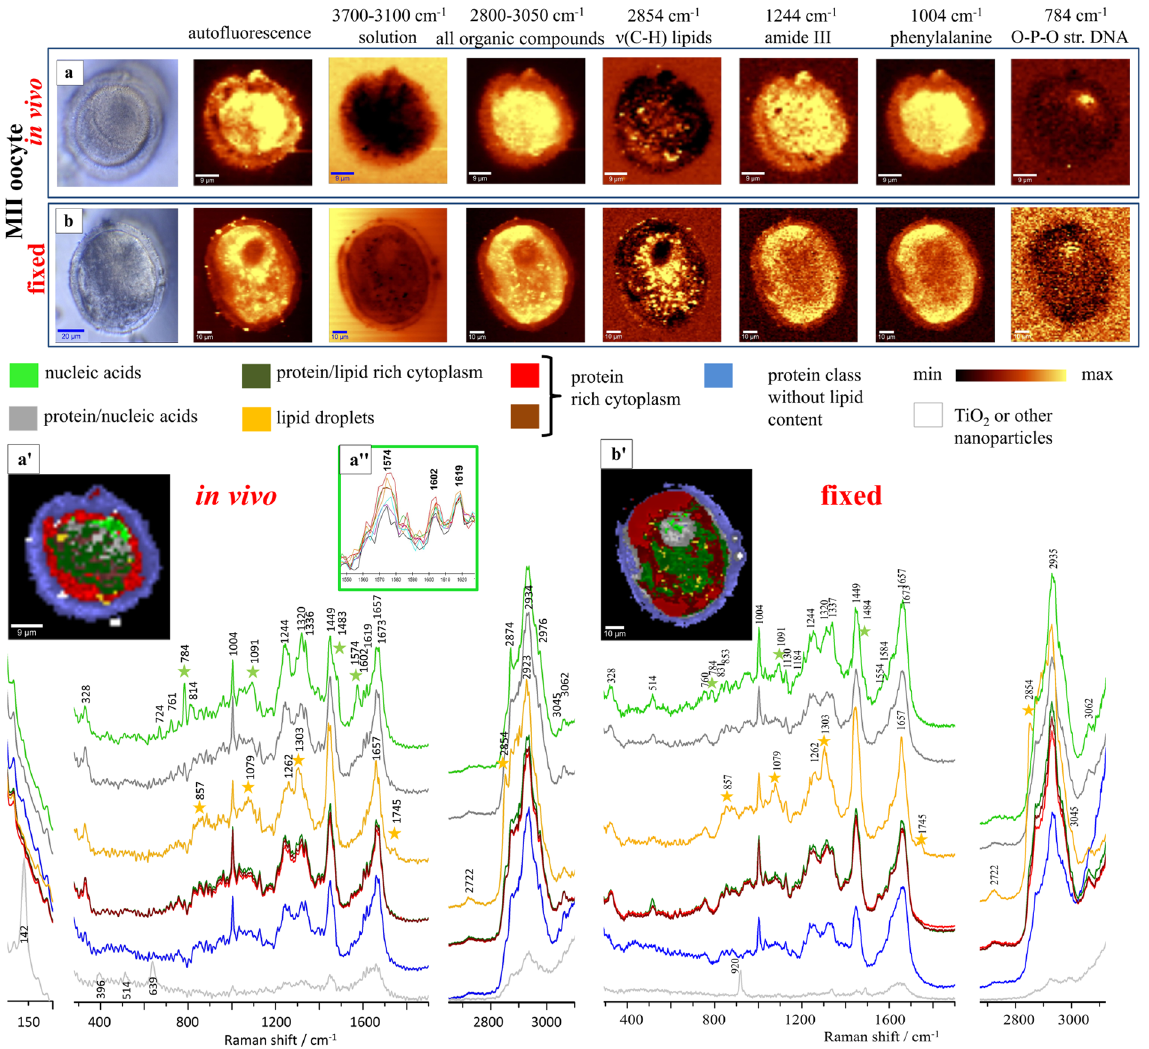
Figure 1. A photomicrograph of ( a ) functional and ( b ) fixed oocytes investigated with the use of air objective (100 × /0.90NA) in the MII stages; Integration Raman maps of a specific bands were obtained with 532 nm laser wavelength and with a sampling density of 1 μ m (maximal spatial resolution equal to 0.33 μ m); K–means Clustering (KMC) results with the 8 main classes were presented with average spectrum for each class. In a” we have additionally presented the zoom-in of the spectral region showing the band at 1602 cm − 1 for the single spectra extracted from the nucleic acids class, which is only observed in the in vivo state. The Raman intensities in the region of 300–1900 cm − 1 were scaled by factor of 2 comparing to CH-stretching region and lower region below 300 cm − 1 . A spectral class corresponding to substrate signal observed surrounding the oocytes was removed from the image (black